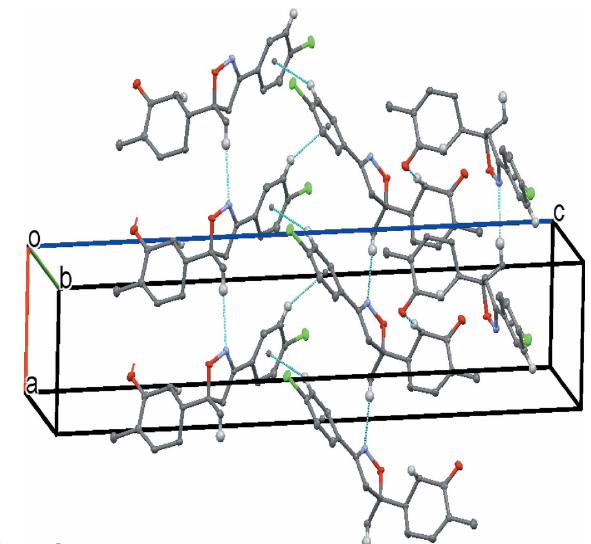
Figure 2 Partial packing diagram of the title compound, showing C—H (cid:2)(cid:2)(cid:2) O, C—